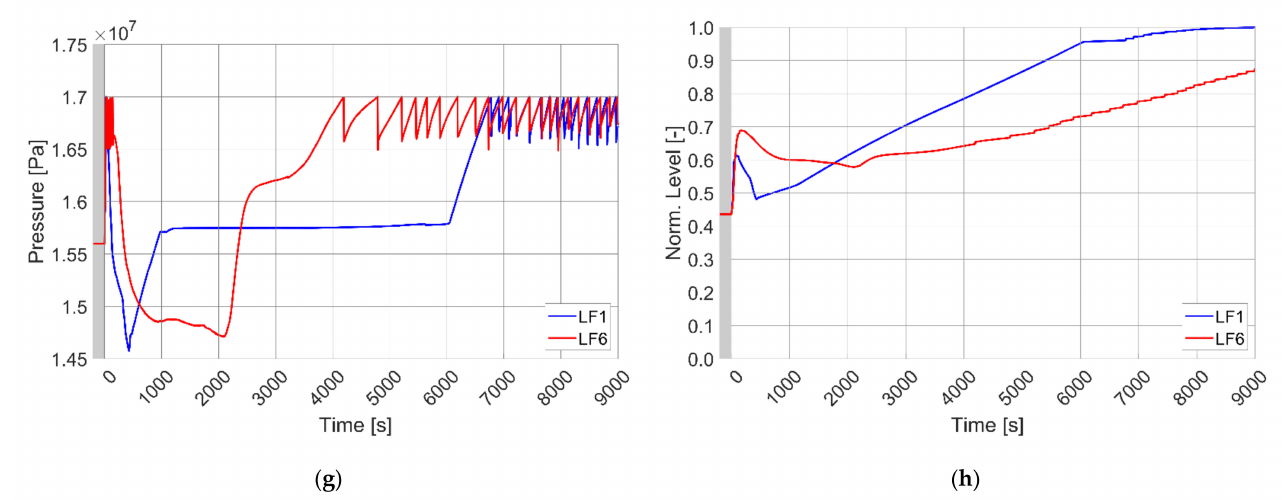
Figure 10. Comparison between LF1 and LF6 transients: ( a ) BZ PHTS water temperatures at BB inlet & outlet (all sectors, early time, COB segment); ( b ) Pressure in BZ PHTS (early time); ( c ) PCS pressure at OTSGs secondary side outlet (early time); ( d ) Mass flow elaborated by BZ loop 1 MCP 1 (full range); ( e ) BZ PHTS water temperatures at OTSG inlet & outlet (loop 1, full range); ( f ) Collapsed level in loop 1 OTSG secondary side riser (R) and lower downcomer (D) (normalized, full range); ( g ) Pressure in BZ PHTS (full range); ( h ) Collapsed level in BZ pressurizer (normalized, full